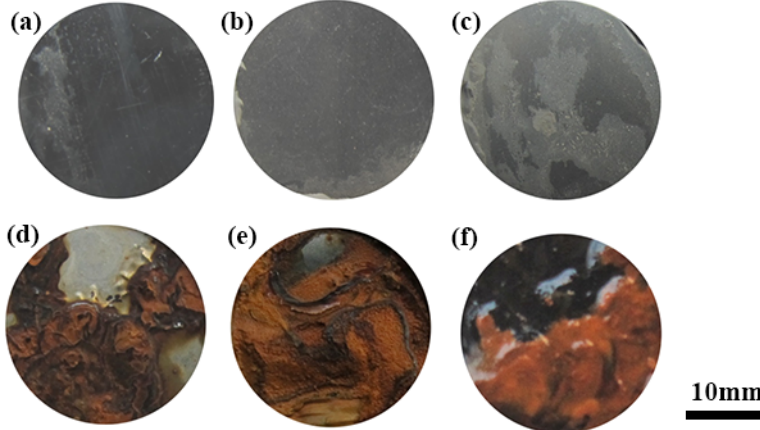
Figure 9. Morphology of 1Cr15 stainless steels after salt spray corrosion of ion nitriding samples for 360 h under different conditions: ( a ) BM; ( b ) 250 °C for 24 h; ( c ) 300 °C for 24 h; ( d ) 350 °C for 24 h; ( e ) 400 °C for 24 h; ( f ) 450 °C for 24 h.